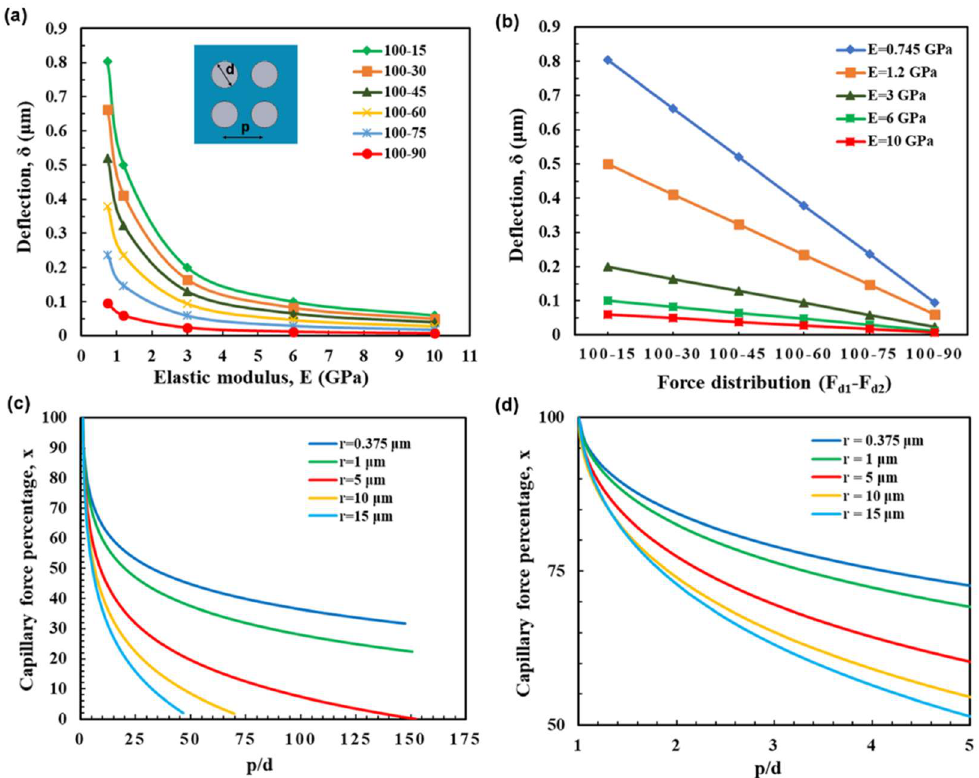
Figure 4. ( a ) Plot showing the effect of elastic modulus on the micropillar deflection for partially immersed four micropillar configuration for different combinations of capillary force distribution percentage ( F d ). ( b ) The deflection values plotted against the force distribution (instead of elastic modulus, E ). ( c ) Plot showing the effect of micropillar geometry (diameter, d = 2 r and pitch, p ) on the capillary force percentage ( x ). The capillary interaction force decreases with increasing pillar separation distance ( p ). ( d ) The zoomed in portion of the plot in ( c ) for p / d ranging between 1 and